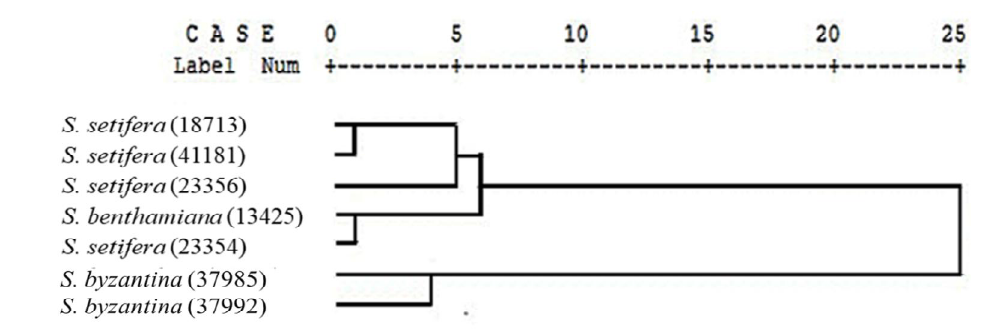
Fig. 2. Ward cluster dendrogram based on all the studied chromosomal traits of seven populations of the studied Stachys